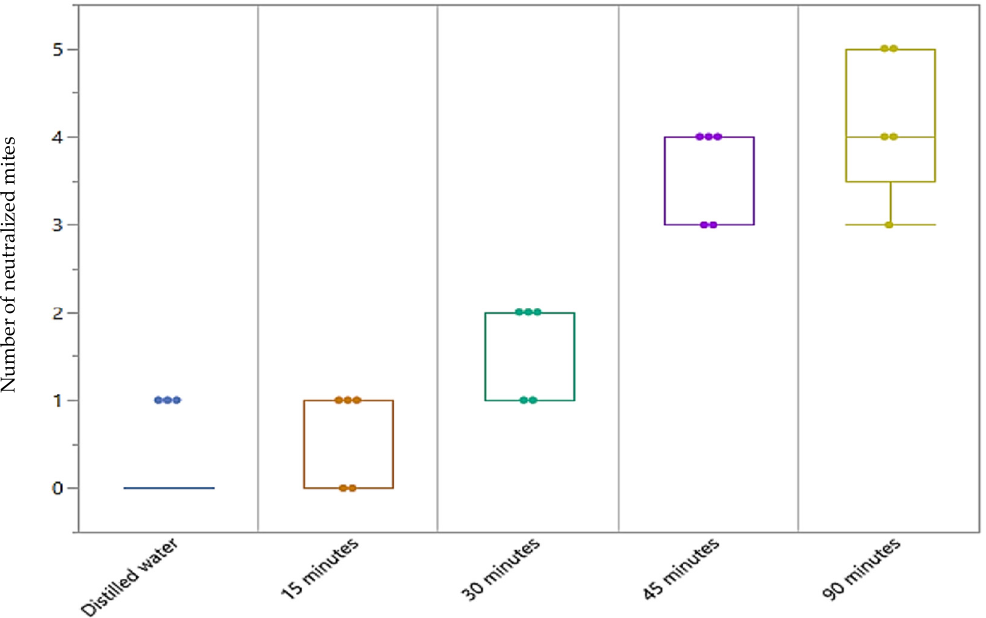
Figure 2. Representation of mites recorded as neutralized after 48 h of exposure at each time interval (15-min exposure vs. 30 min exposure, p = 0.98; 15 min exposure vs. 45 min exposure, p = 0.0116; 15-min exposure vs. 90 min exposure, p = 0.0015, respectively, calculated with Dunn’s Multiple Comparison with Bonferroni correction).